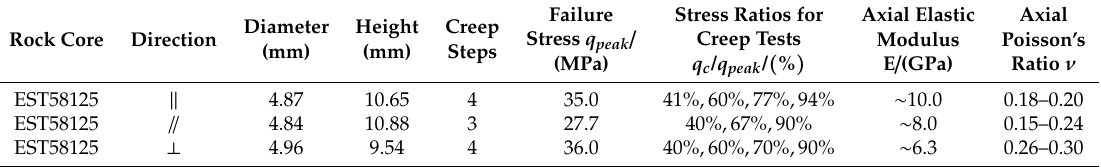
Table 1. Elastic and strength properties of the Callovo-Oxfordian (COx) claystone and stress steps for creep